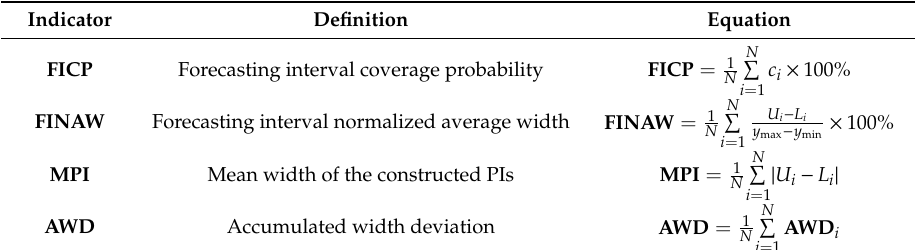
Table 4. Interval prediction evaluation